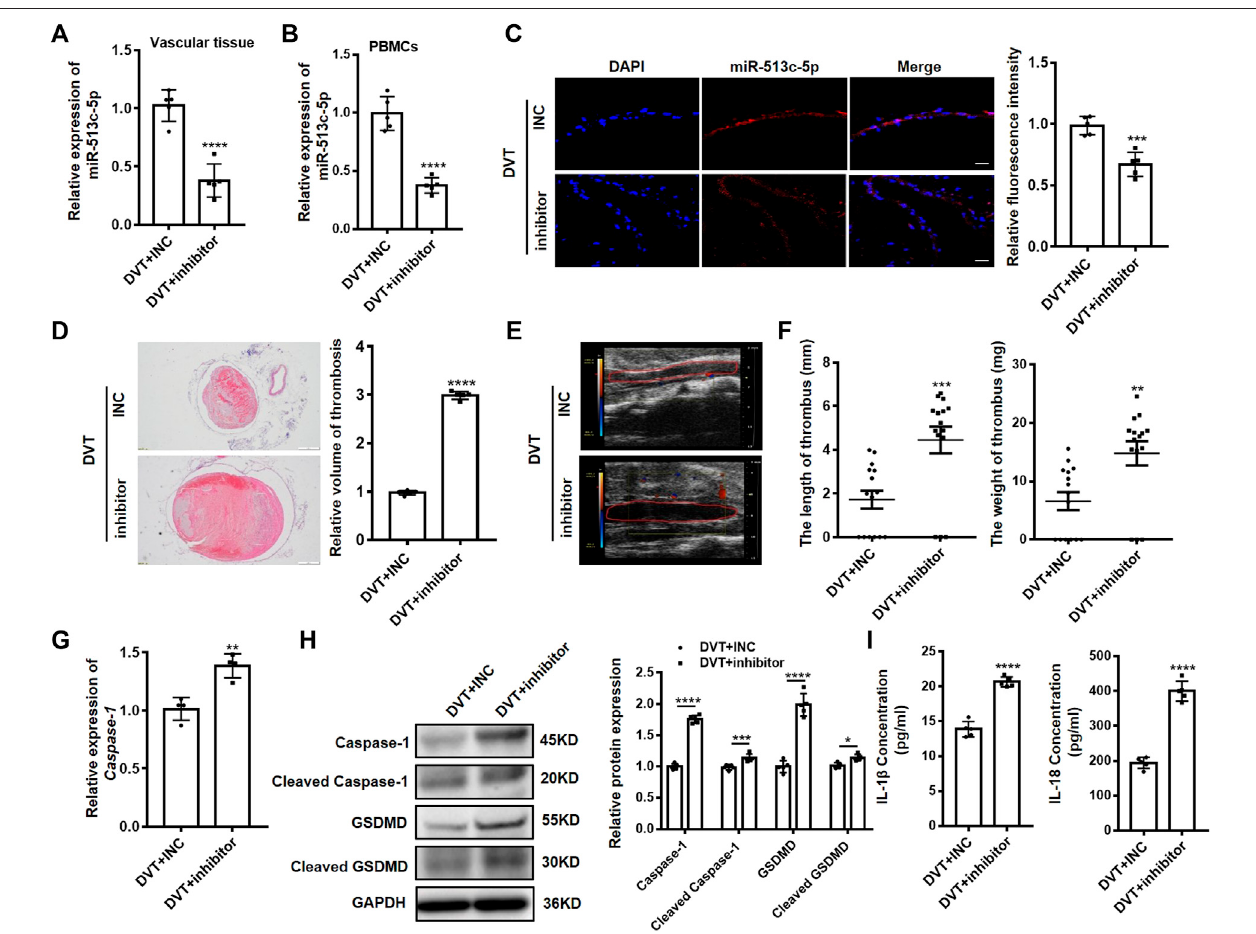
FIGURE 6 | Knockdown of miR-513c-5p promotes pyroptosis of VECs and DVT formation by increasing caspase-1. (A) The expression level of miR-513c-5p in vasculartissuewasdetectedbyqRT-PCRinDVTmicetreatedwithINC,miR-513c-5pinhibitor,respectively. (B) ExpressionofmiR-513c-5pinPBMCswasdetectedby qRT-PCRinDVTmicetreatedwithINC,miR-513c-5pinhibitor,respectively. (C) ConfocalmicroscopyimagesofmiR-513c-5pexpressioninvasculartissues(miR-513c- 5p,red;DAPI,blue)(magni fi cation,×200).Scalebars=100 μ m. (D)H & E stainingofserialcrosssectionsofinferiorvenacava(IVC)fromDVTmicetreatedwithINC, miR-513c-5p inhibitor at 48 h (magni fi cation, ×40). Scale bars = 500 μ m. (E) Representative images of thrombi in each treatment group were detected by vascular ultrasoundat48 hpost-operation. (F) Thrombuslengthandweightat48 hpost-operationinthedifferenttreatmentgroups( n =15ineachgroup). (G) Caspase-1mRNA level was determined by qRT-PCR in vascular tissue of each treatment group. (H) Caspase-1 and GSDMD protein levels were determined by Western blot in vascular tissue of DVT mice treated with INC, miR-513c-5p inhibitor. (I) IL-1 β and IL-18 protein levels in vascular tissue were determined by ELISA in INC, miR-513c-5p inhibitor treated DVT mice models, respectively. * p < 0.05, ** p < 0.01, *** p < 0.001, **** p <